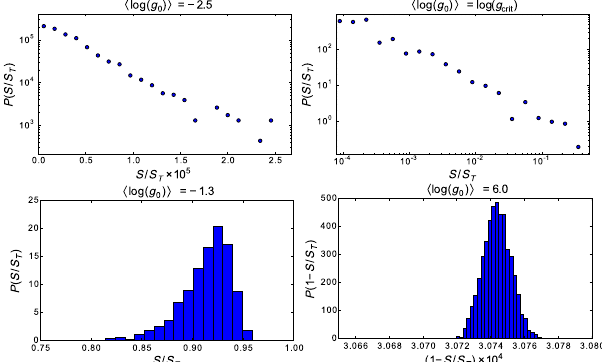
6. Distributions of the entanglement entropy divided by its thermal value for systems of length L=l 0 ¼ 10000 calculated in the different regimes: the localized phase (top-left panel), critical point (top-right panel), Griffiths phase (bottom-left panel), and diffusive regime (bottom-right